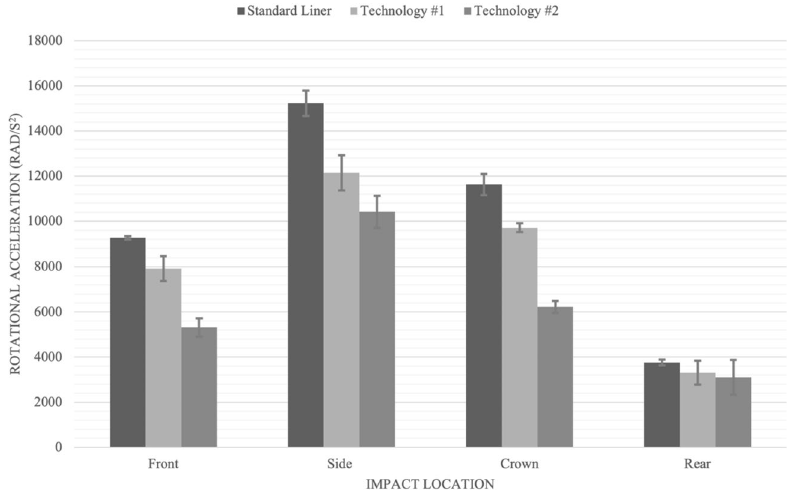
Figure 5. Bar graph displaying peak rotational acceleration results in radians per second squared (Rad/s 2 ) for impact locations and helmet type.